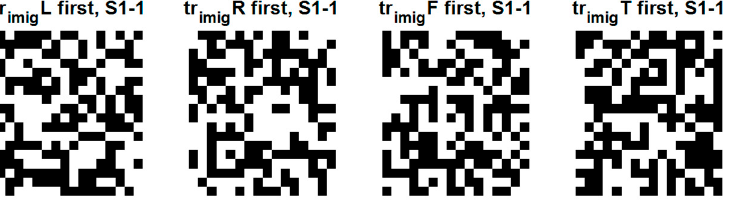
Figure 15. Training QR code realization of subject 1 at trial 1 for 4 classes: left, right, feet, and tongue (18 × 16) in C4D2a_4C.